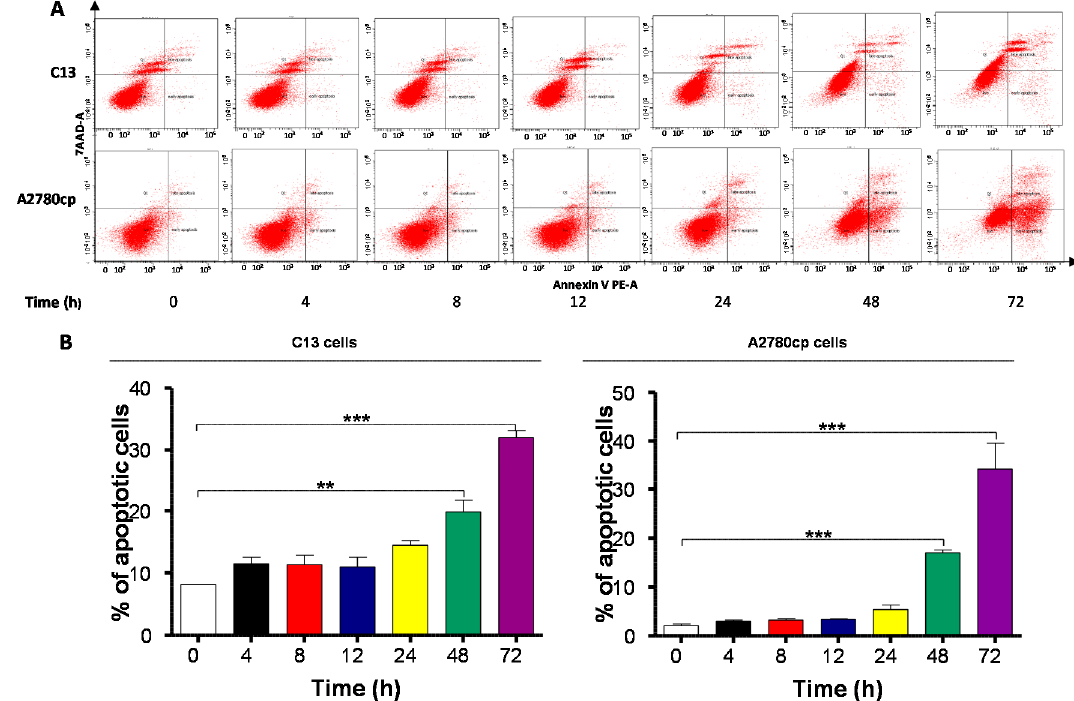
Figure 6. Danu induces apoptotic cell death in C13 and A2780cp cells over a 72-h treatment period. C13 and A2780cp cells were incubated with Danu 0.5 μ M for 4, 8, 12, 24, 48, and 72 h and then subject to flow cytometry. ( A ) Flow cytometric plots of specific cell population (live, early apoptosis, and late apoptosis) in C13 and A2780cp cells and ( B ) bar graphs showing the percentage of apoptosis of C13 and A2780cp cells. Data represent the mean ± SD of three independent experiments. ** p < 0.01 and *** p < 0.001 by one-way analysis of variance.